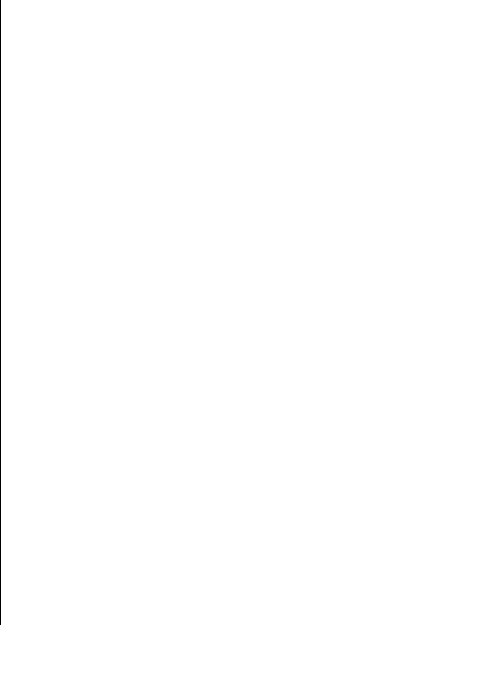
Table 2. Data collection and refinement